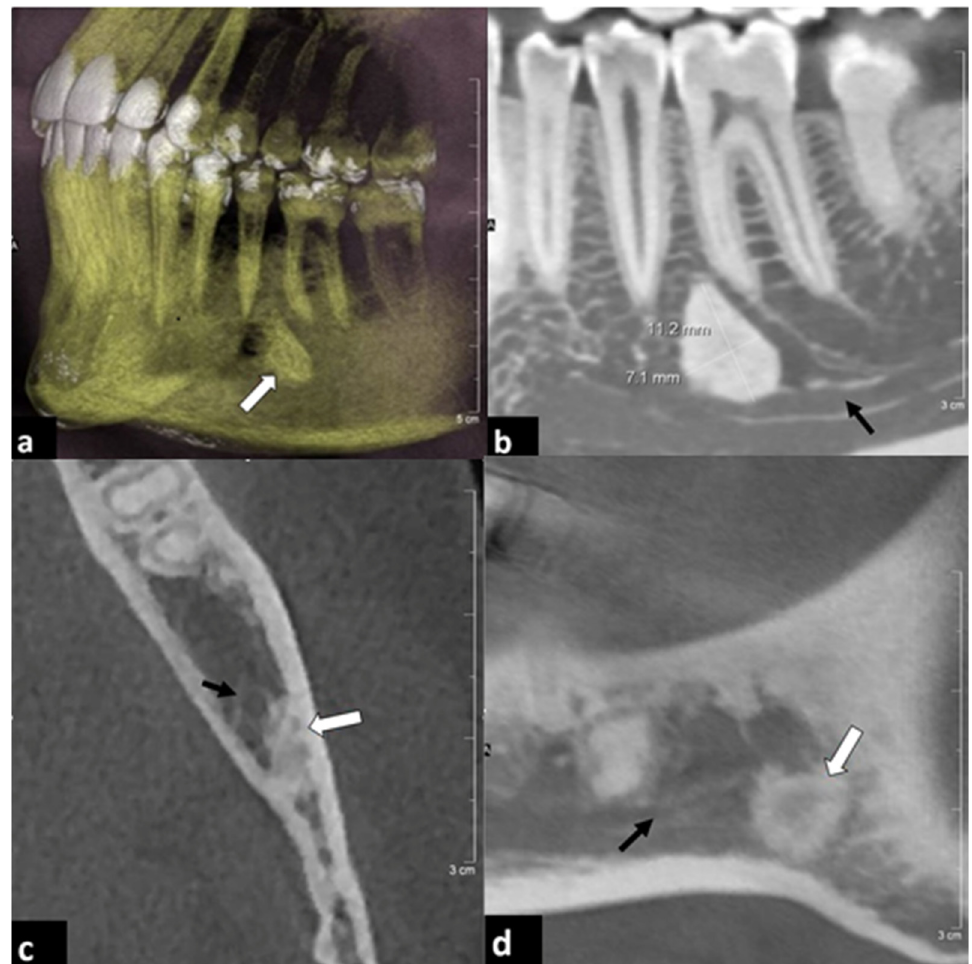
Figure 3. Two examples of osseous incidental findings. ( a , b ) Forty-four year old female patient. CBCT was performed prior to bisphosphonate medication due to osteoporosis. ( a ) Volume rendering and ( b ) parasagittal reconstruction showed an osteoma (white arrow) between the dental roots of teeth 35 and 36. The alveolar nerve canal (black arrow) was likely to be narrowed. ( c , d ) Seventy-five year old female patient with history of breast cancer and numbness of the lower left jaw. ( c ) Paraxial and ( d ) parasagittal reconstructions showed a sclerotic lesion (white arrow) with blurred contact to the alveolar nerve (black arrow). Further clinical evaluation revealed the diagnosis of an osteoblastic bone metastasis.